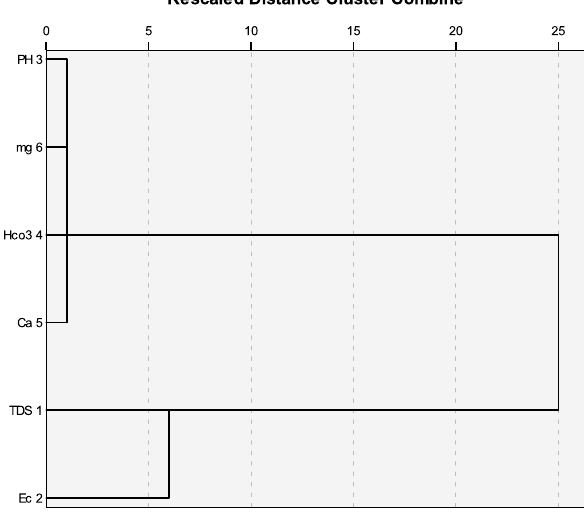
Fig. 3 Dendogram using average linkage between